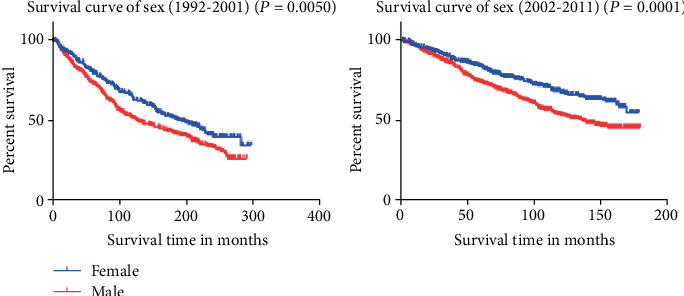
Kaplan-Meier estimate of overall survival as a function of sex in the 1992-2001 and 2002-2011 patient cohorts.